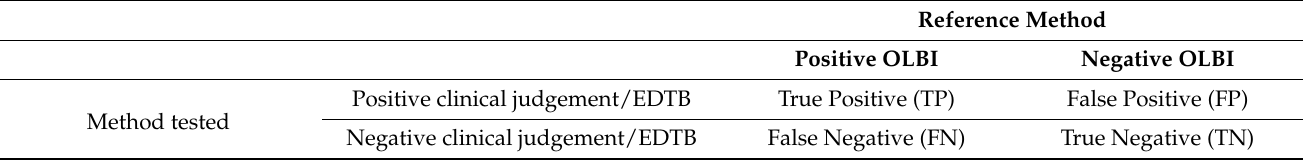
Table 4. Theoretical table to test the validity of the early detection tool of burnout